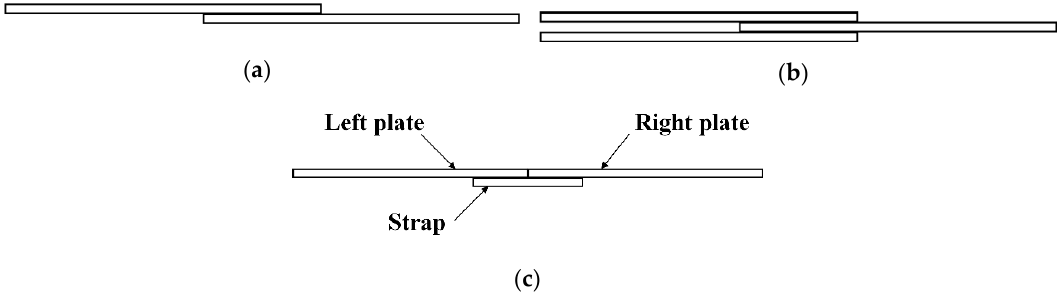
Figure 1. Several typical riveted joints configurations: ( a ) single-lap joint; ( b ) double-lap joint; and ( c ) single strap butt joint.